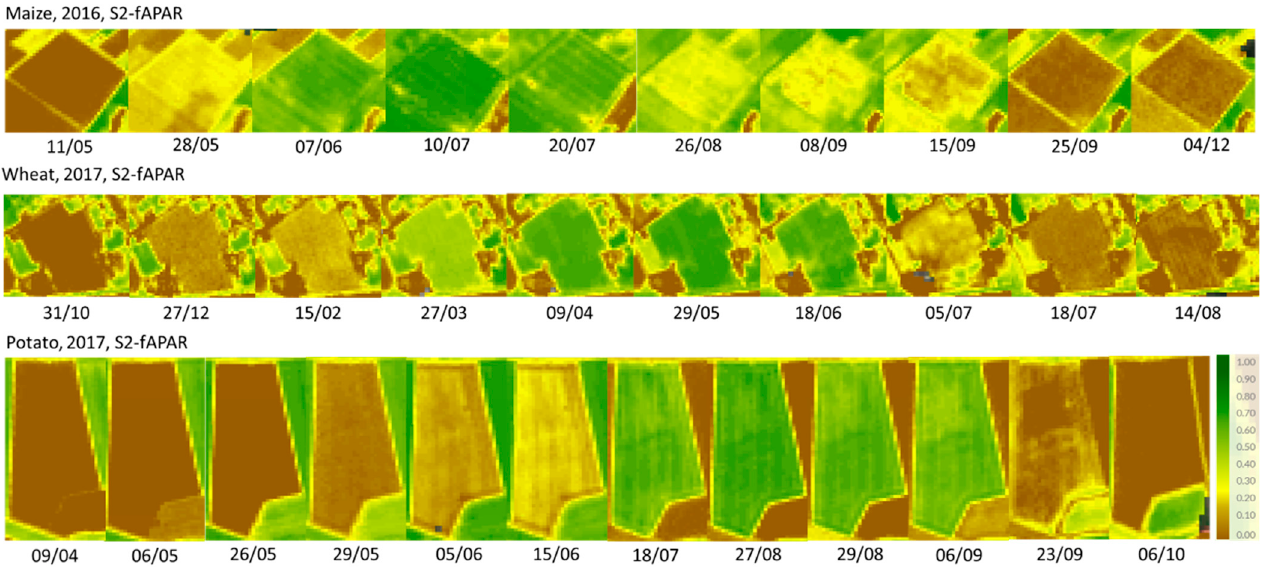
Figure 9. DMC-derived fCover and fAPAR versus days after planting/sowing (DAP) for maize fields in 2015 and related BBCH codes versus DAP.